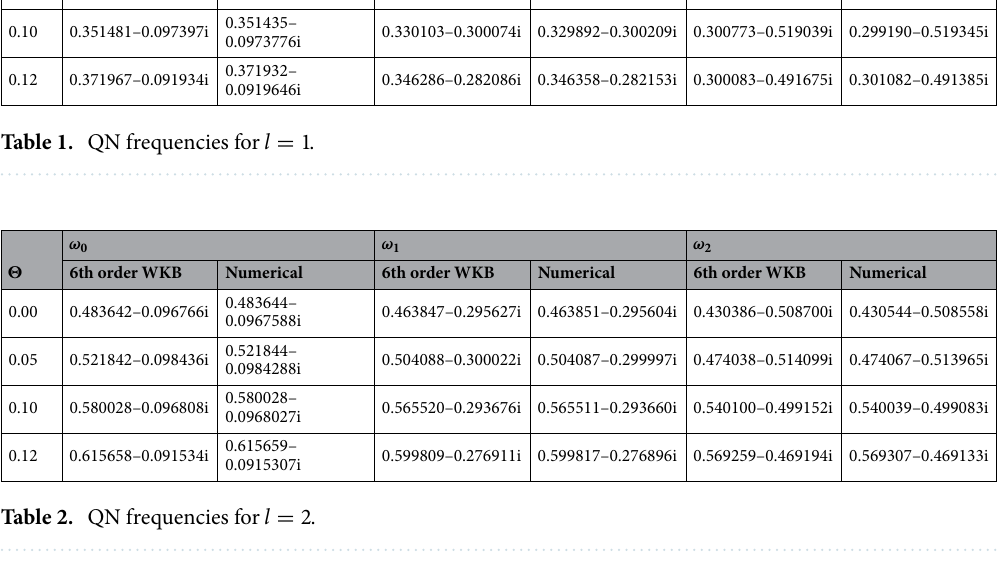
1, 2, 3 (from left to right) and (cid:31) =